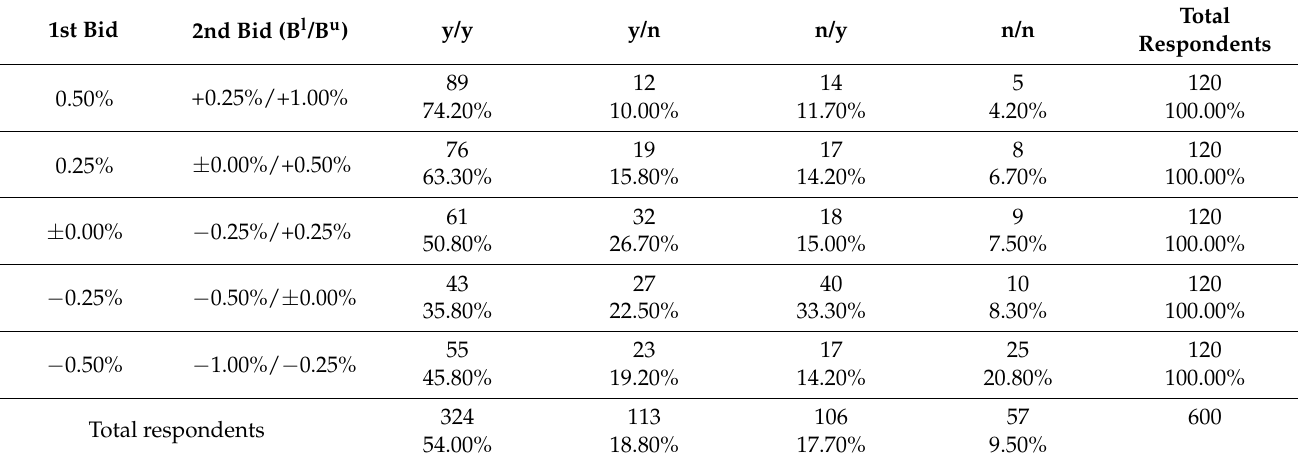
Table 6. Distributions for the bid responses among the five groups of respondents ( n =